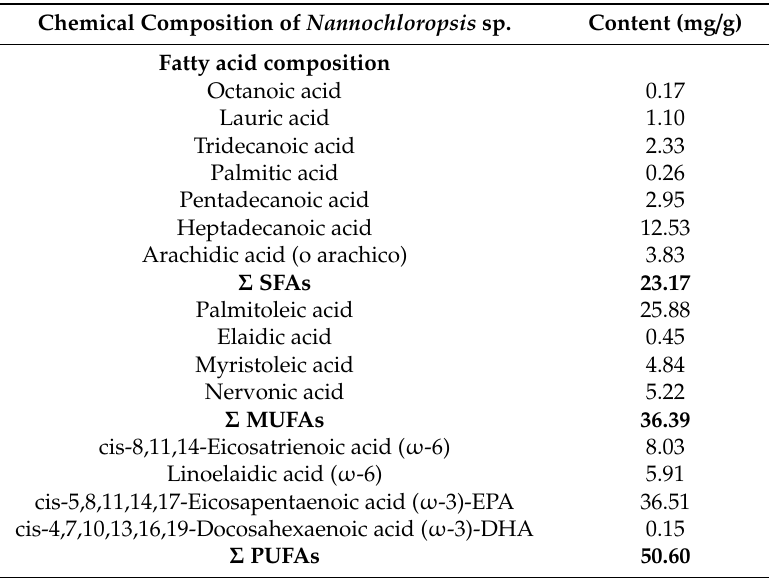
Chemical Composition of Nannochloropsis